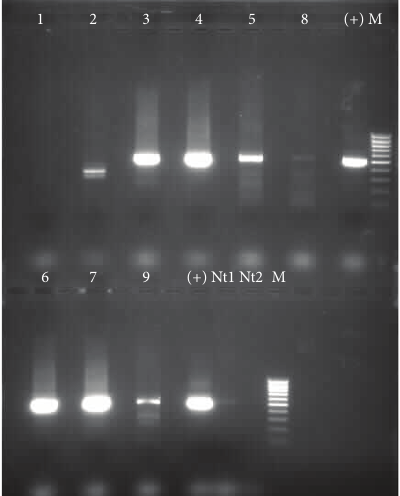
Figure 2: Electrophoretic separation of 𝛽 -giardin PCR products (511bp). Lanes 1–9, G. duodenalis positive samples through micros- copy; lanes (+), positive control ( G. duodenalis DNA, strain Port- land-1, ATCC 30888DTM LGC Promochem); lanes M, 100bp lad- der; lanes Nt1 and Nt2, negatives controls (no DNA) from the first and the second PCR reaction,